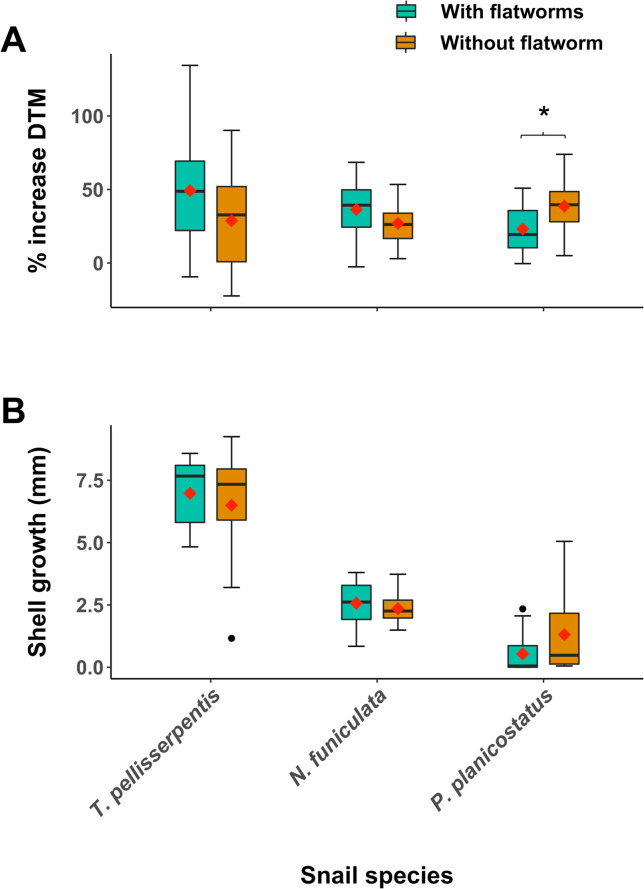
Effect of flatworm infestation on snail growth performances.Box plots of (A) percentage increase in snail dried tissue mass (DTM) and (B) growth in the shell aperture lip (mm) for Tegula pellisserpentis, Nerita funiculata, and Planaxis planicostatus with (turquoise box) and without (dark orange box) flatworms during the field experiment. Mean values for different treatment groups are represented by red diamond symbols. The asterisk (*) indicates a significant difference (P < 0.05).